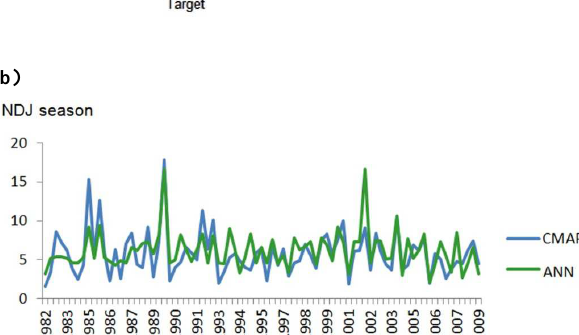
Fig. 2. Validation results to the north grid box over the NEB region: Figure 2 2 (a) Scatterplots of observed × downscaled precipitation using the nonlinear ANN (R-value=0.83). (b) The corresponding monthly time series. The scatterplots are adapted from the Matlab and the solid gray line represents the fit model.